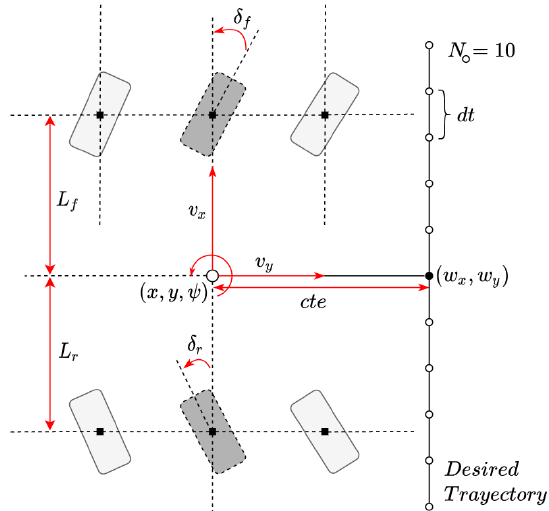
Figure 16. MPC vehicle